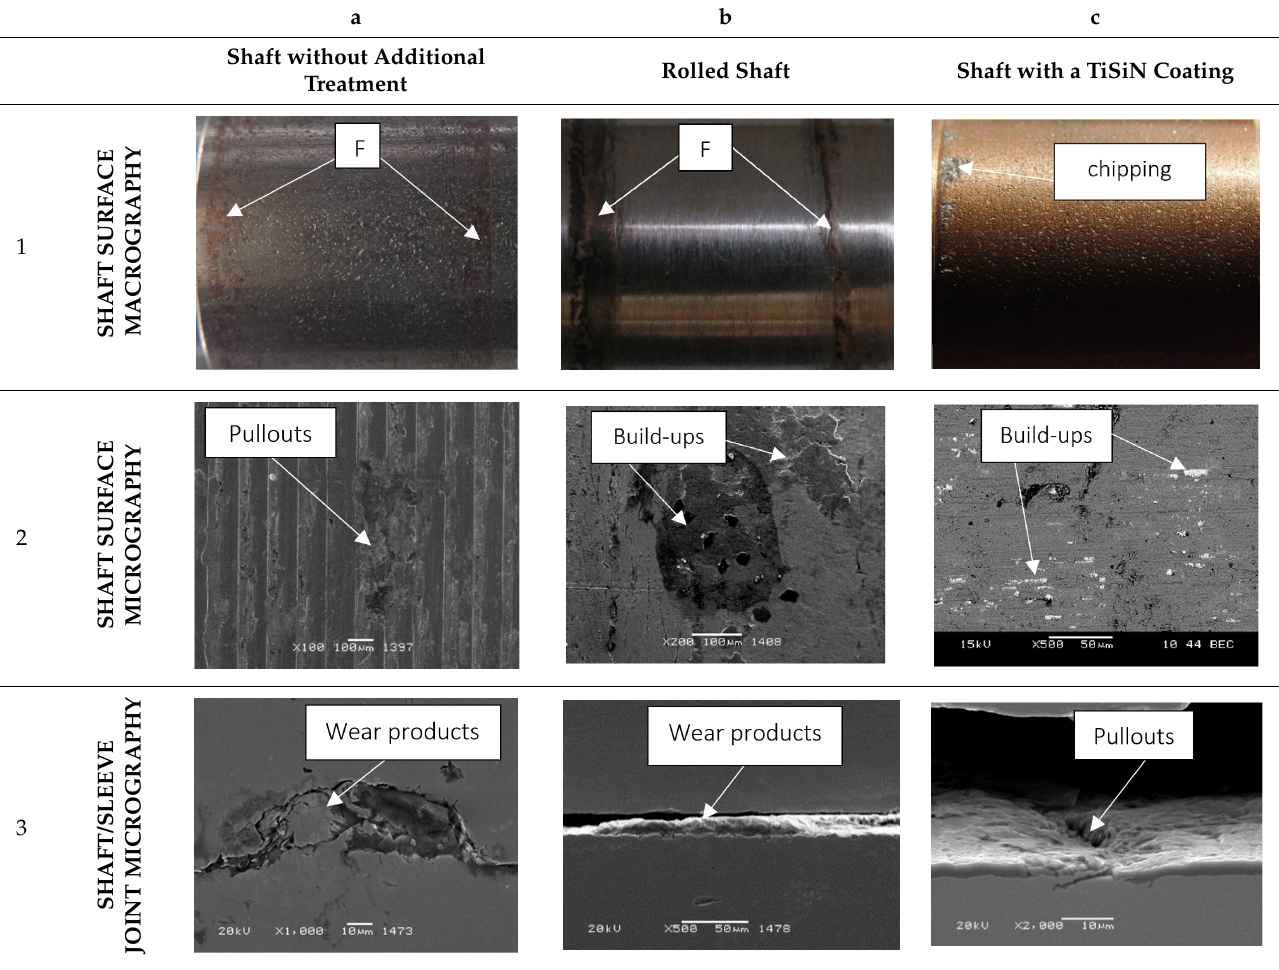
joint contact surface area, and the wear is only caused by adhesion attraction with the durable intersurface bonds. Table 5. Results of laboratory observations of the shaft surface and the shaft/sleeve contact surface following wear tests (F- fretting wear). a b c Shaft without Additional Rolled Shaft Shaft with a TiSiN Coating Treatment